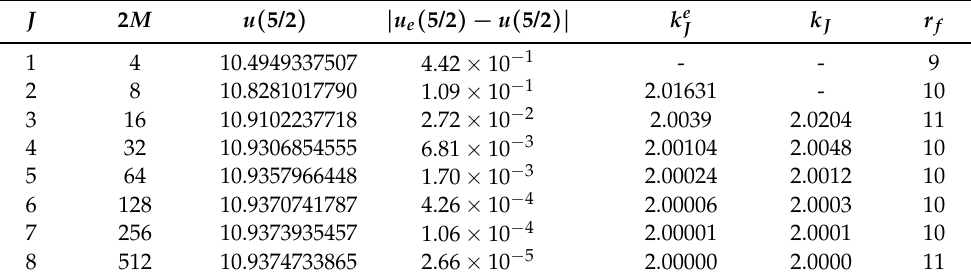
Table 5. Solutions to (19) where u e ( 5/2 ) = 10.9375 using HWM.